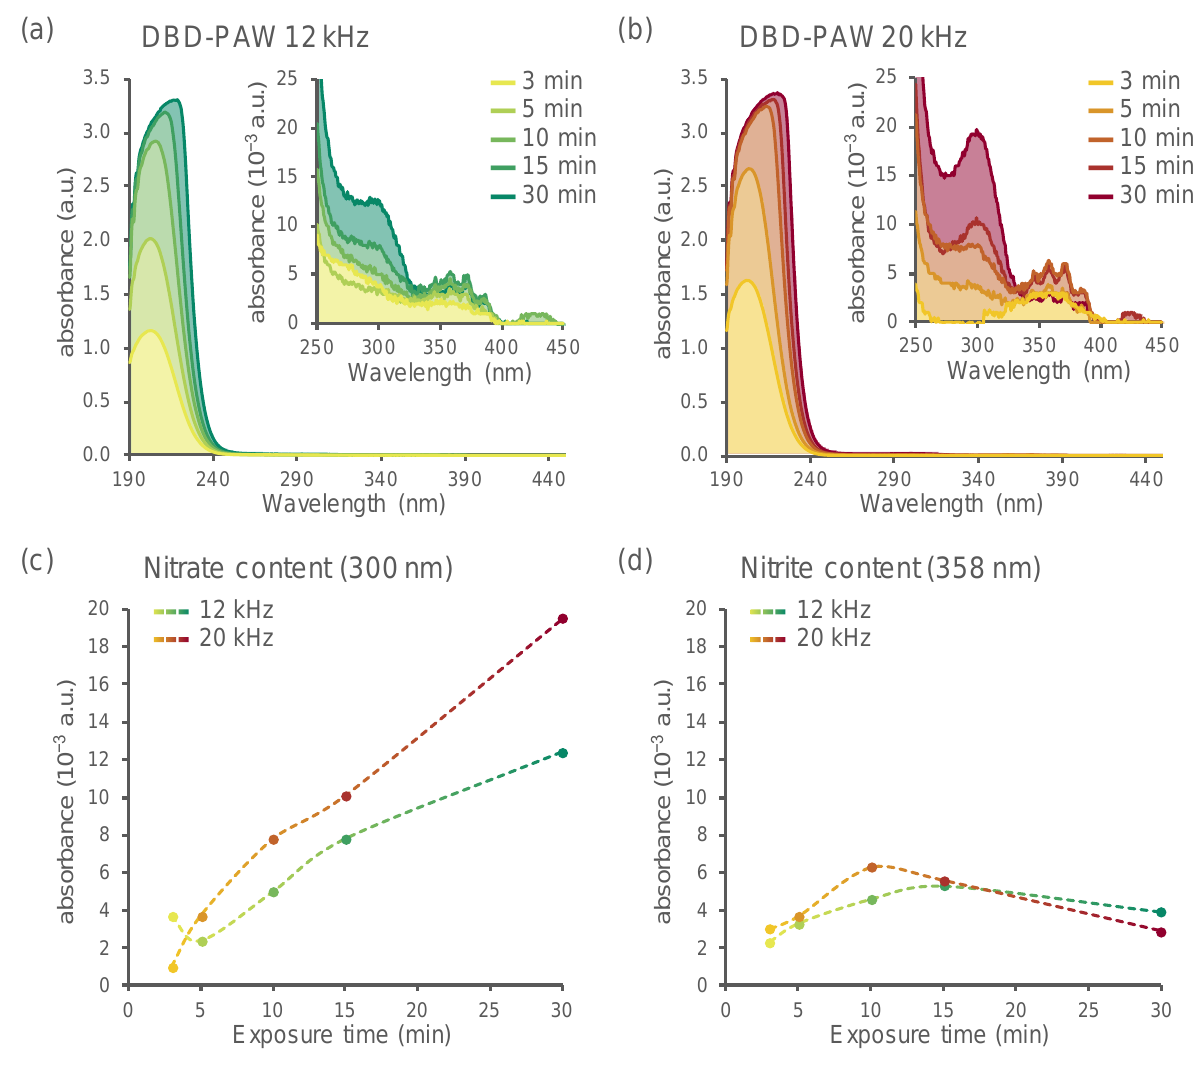
Figure 2. Detection of the main nitrogen species in DBD-PAW by spectrophotometric analyses. UV–Vis spectral analyses were performed on DBD-PAWs obtained at different discharge frequencies: ( a ) 12 kHz (green shades); ( b ) 20 kHz (red shades). DBD-PAWs were obtained by progressively increasing the exposure time of deionized H 2 O to DBD cold plasma (from 3 to 30 min). The inset magnifications ( a , b ) reveal the presence of distinctive bands in the regions related to nitrates (NO 3 − ) and nitrites (NO 2 − ). Data shown in ( a , b ) are representative traces (solid lines and areas under the curve) of the absorbance spectra in the 190–450 nm region, which were quantified at 300 nm ( c ) and 358 nm ( d ) to provide comparative estimations for NO 3 − and NO 2 − contents among the distinct